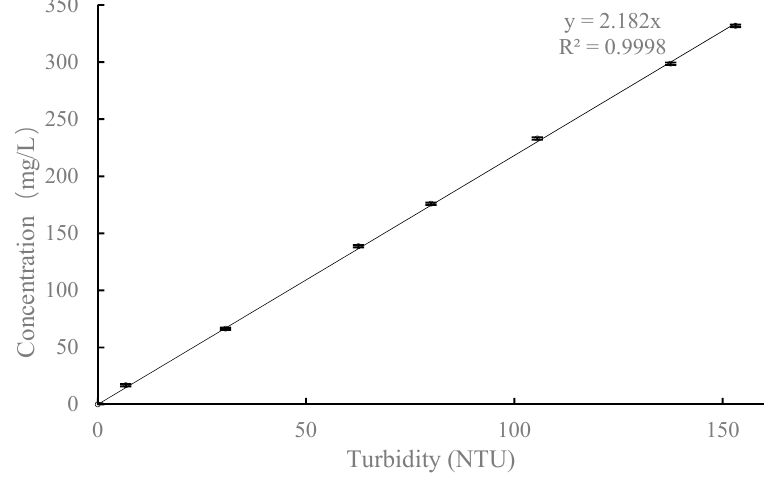
Figure 2. Correlation between turbidity and concentration.